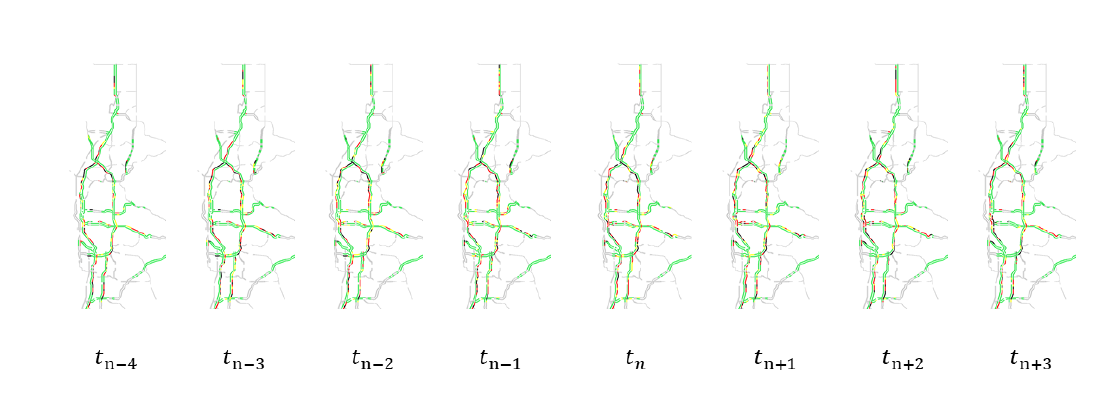
Figure 3. A sample of a sequence of images with only road networks organized chronologically for further